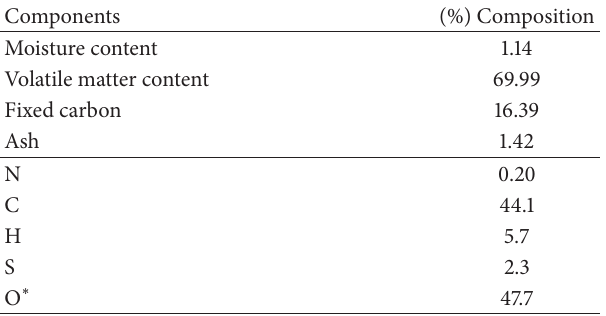
Table 1: Proximate and ultimate analysis of sugarcane bagasse.